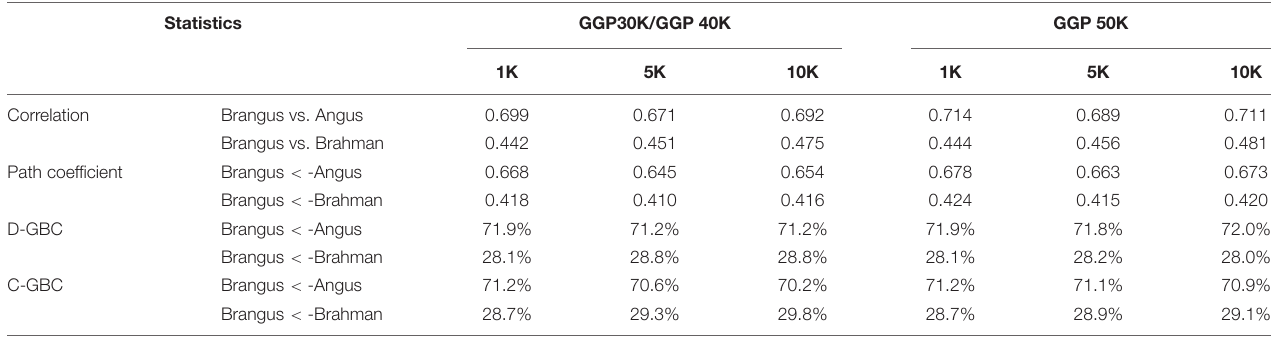
TABLE 3 | Path analysis using the correlation data for 7,969 Brangus animals with two ancestral breeds (Angus and Brahman) as the reference and three SNP panels (1K, 5K, and 10K). Statistics